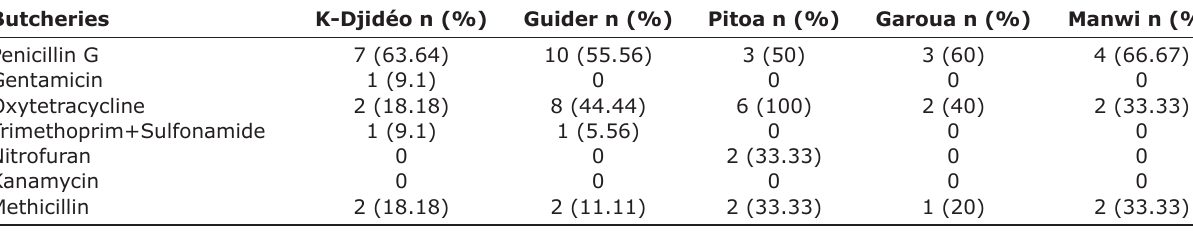
Table-6: Resistance to Staphylococcus with positive coagulase in the butcheries. Butcheries